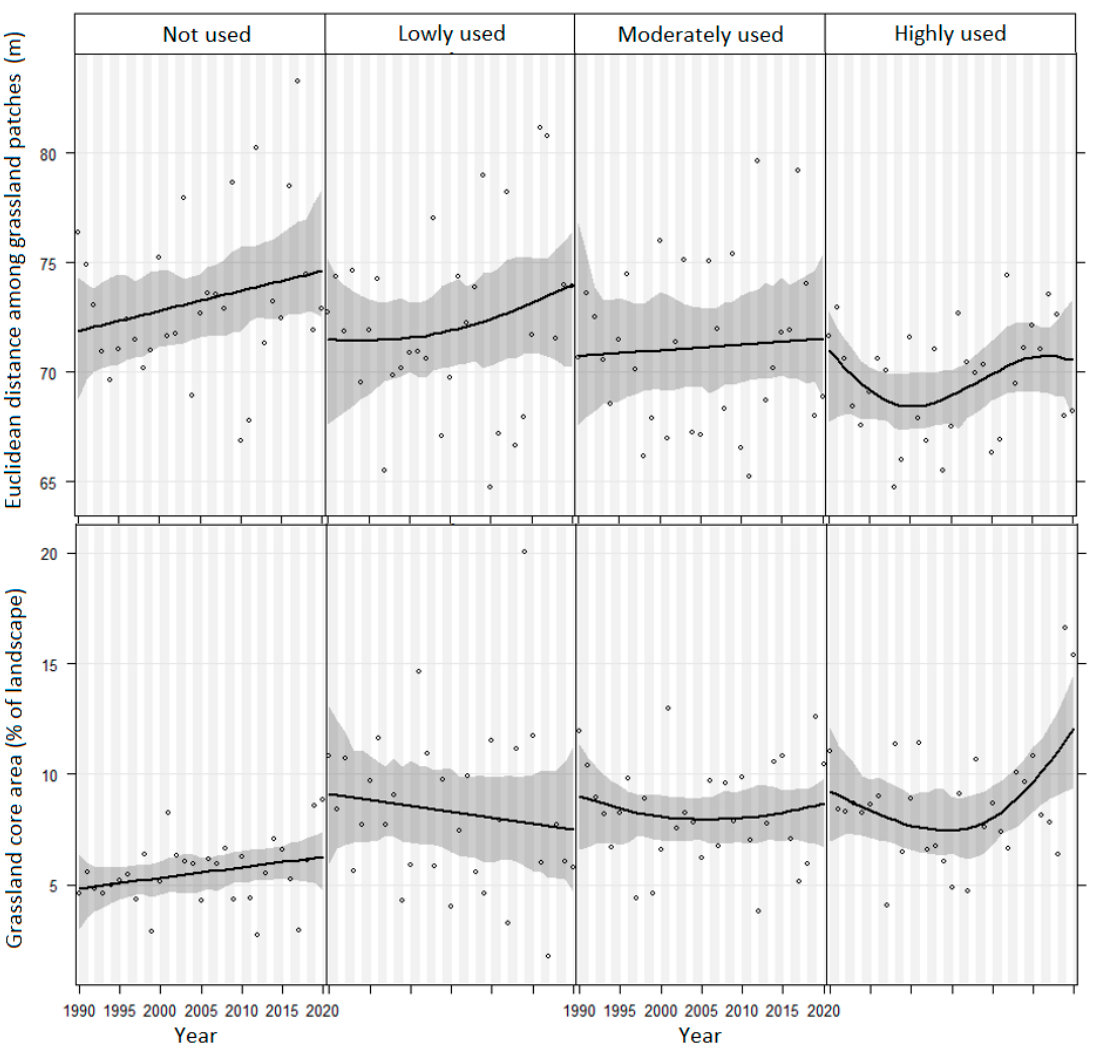
Figure 8. Temporal evolution (1990–2020) of the mean Euclidean distance between grazing patches (m) and of the percentage of the landscape that is grassland core area (%) in the merino passes grouped according to the time of use by sheep (not used, lowly used, moderately used, and highly used). The dots indicate the mean values for each year, the lines predicted values by generalized additive models, and the shading of the 95% con fi dence intervals.